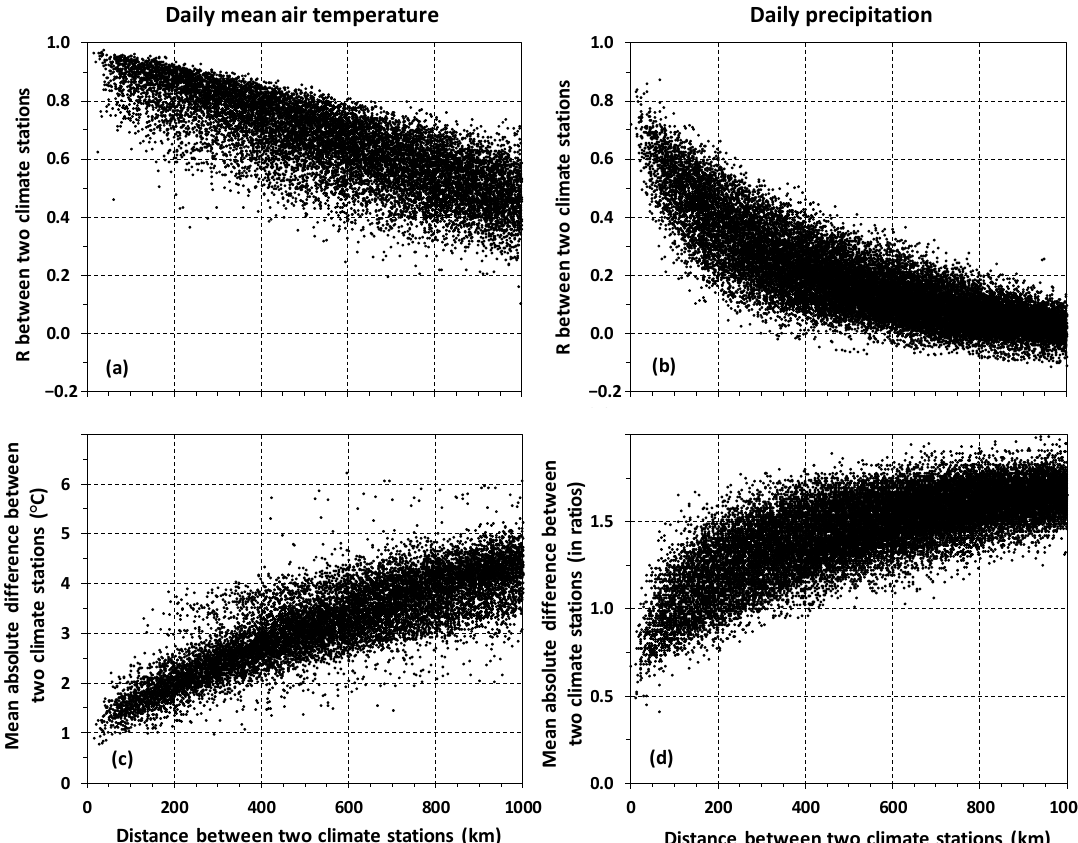
Figure 3. Correlation coefficients (R) between two climate stations for ( a ) daily mean air temperature and ( b ) daily precipitation and mean absolute differences between two climate stations for ( c ) daily mean air temperature and ( d ) daily precipitation. They were calculated using the deviations (differences for air temperature and ratios for precipitation) from the long-term seasonal patterns, which were linearly interpolated from the long-term monthly averages.